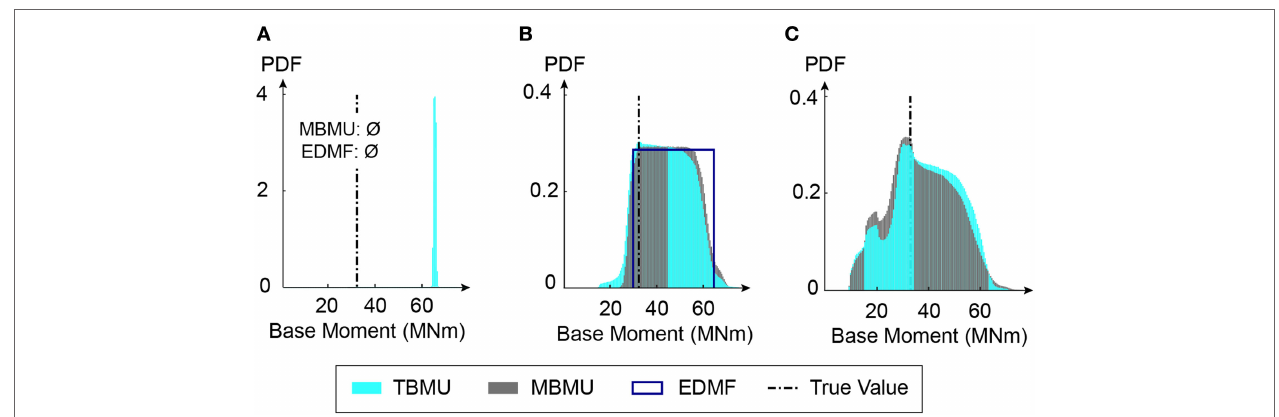
FIGURE 10 | Comparison of predicted absolute maximum base moment during an aftershock for tested identification scenarios. If model errors are ignored (S 1 in Table 2 ), error-domain model falsification (EDMF) and modified Bayesian model updating (MBMU) indicate that the wrong model class is used (A) . The vertical axis (probability density function) for measurement uncertainty (A) is increased for better readability. (B) Predefined uncertainty. (C) Parameterized uncertainty.